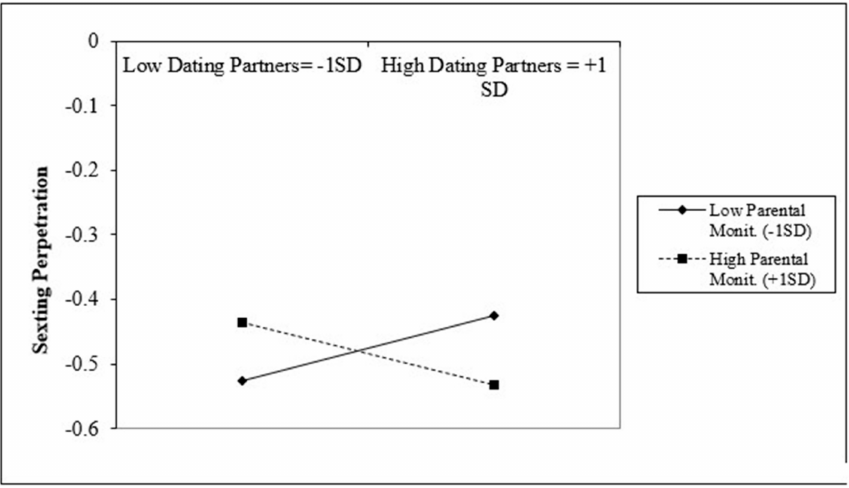
Figure 3. Interaction between number of dating partners and parental monitoring for LGB group.